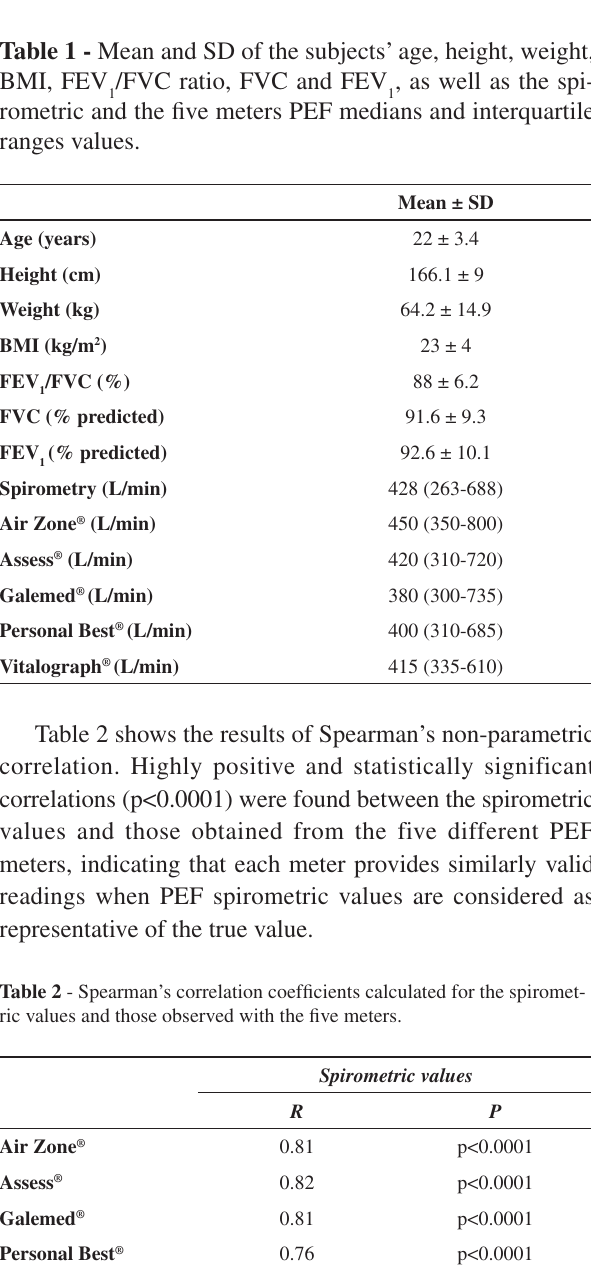
, as well as the spi- 1